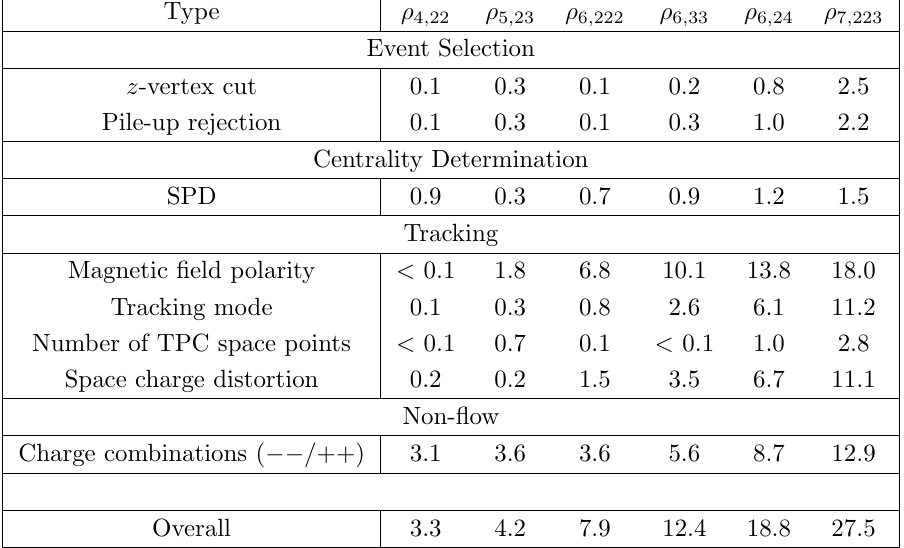
of the higher interaction rates is estimated by comparing results from di(cid:11)erent regions of the TPC, one for (cid:17) > 0 and the other (cid:17) < 0. The maximum uncertainty is evaluated less than 15%. The track reconstruction related uncertainty, referred to as tracking mode, is evaluated by comparing the results obtained with tracks for which the requirement for the number of hits in the ITS layers is changed. In this case, the uncertainty is generally less than 15%, and a maximum 20% is evaluated for (cid:26) . Furthermore, the track selection 7 ; 223 criteria is tightened by increasing the minimum number of the TPC space points from 70 to 90, resulting in uncertainties around 1% to 3%.